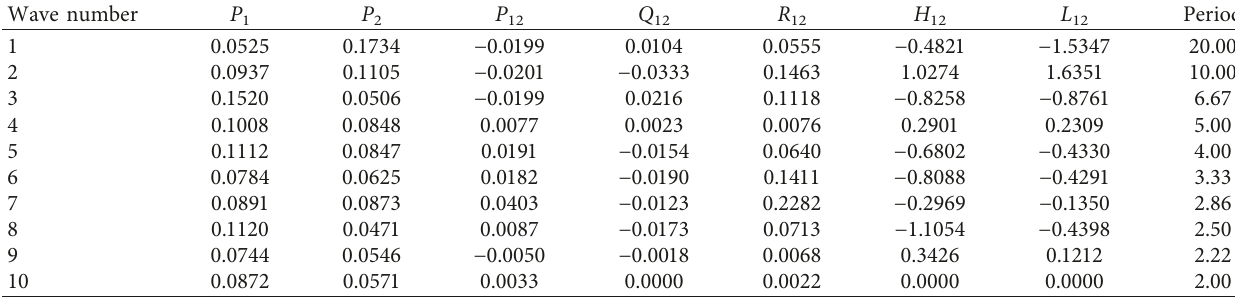
Table 1: Grey association and cospectrum of AQI and housing price in Handan.